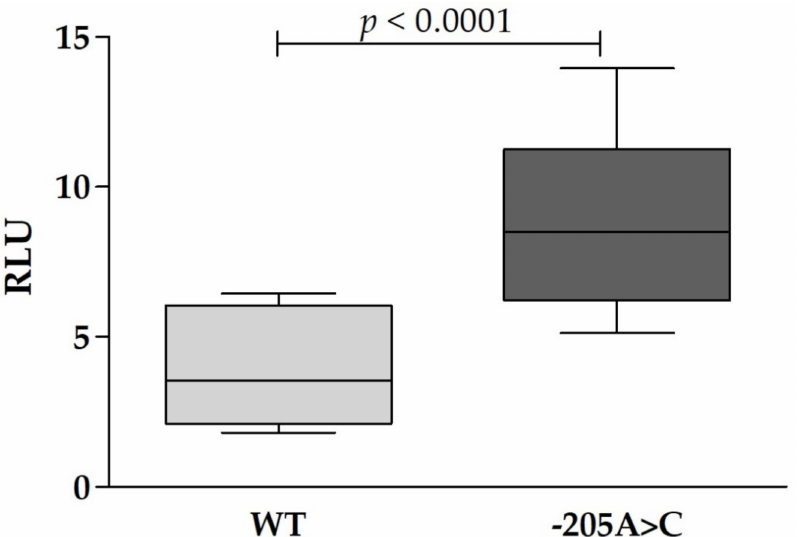
Figure 1. Luciferase assay in HeLa cell line transfected with WT or mutated ferroportin 5 (cid:48) UTR luciferase constructs. Boxes denote lower quartile, mean and upper quartile, and whiskers show maximum and minimum ranges. (RLU = Relative Luciferase